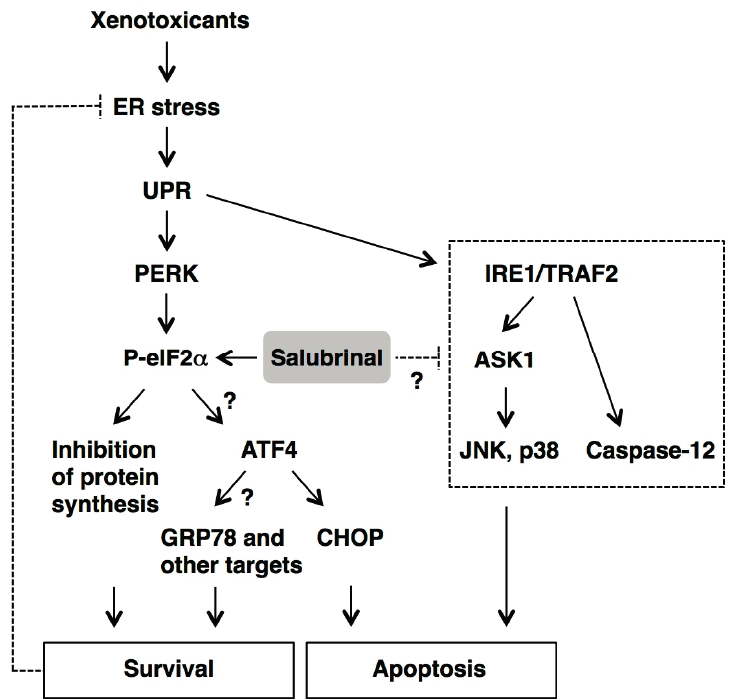
Figure 2. Proposed effects of salubrinal on the xenotoxicant-activated ER stress signaling pathways. Following exposure to xenotoxicants, ER stress activates the double-stranded RNA-activated protein kinase-like ER kinase (PERK)/eukaryotic translation initiation